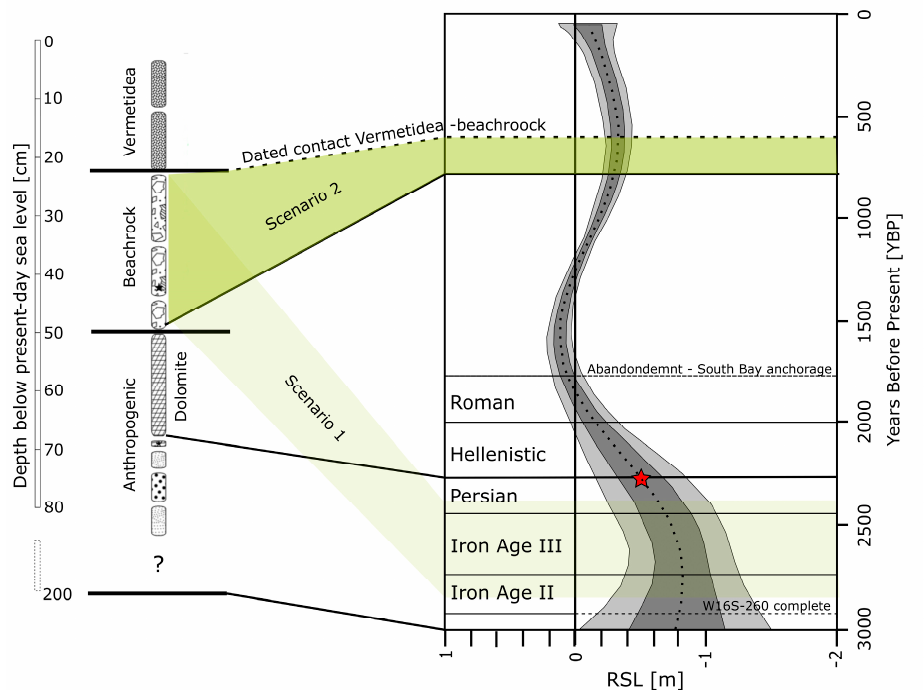
Figure 4. Conceptual model showing the correlation of sea level oscillation (modified after [46]) and the main phases of Core A, which are correlated to years before present (years BCE + 2000) on the basis of deductions explained in the text. Green represents the two possible scenarios for beachrock formation. RSL—relative sea level (in meters). The ages provided indicate the possible periods when the rocks were emplaced up to the dolomite layer. Above the dolomite, ages represent possible dates of formation resulting from anthropogenic influence as explained in the text. Red star marks when sea level was 50 cm below present-day level during the transition between the Persian and Hellenistic periods.